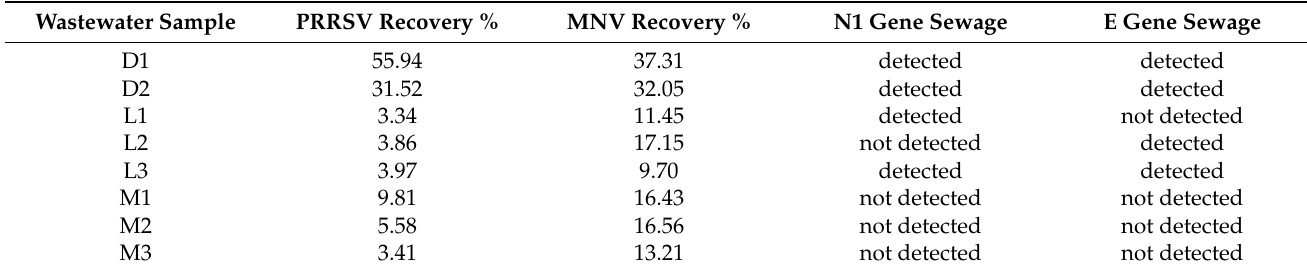
Table 5. Viral recovery in wastewater supernatant spiked with reproductive syndrome virus (PRRSV) and concentrates spiked with murine norovirus